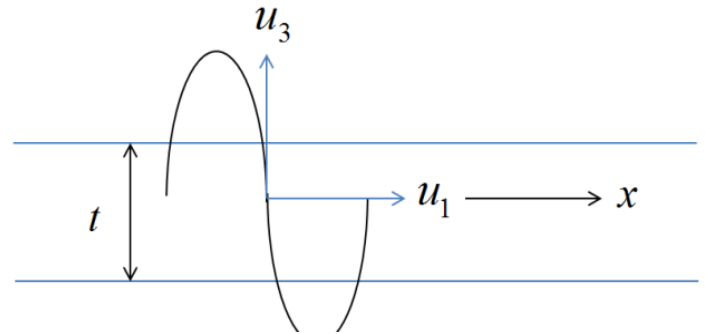
Figure 1. In-plane ( u 1 ) and out-of-plane ( u 3 ) displacement coordinate